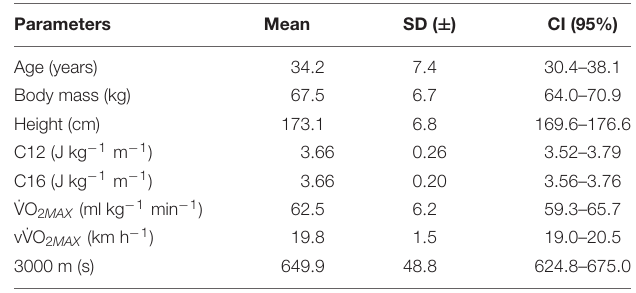
TABLE 1 | Sample characterization in mean, standard deviation (SD), and confidence interval (CI). Parameters